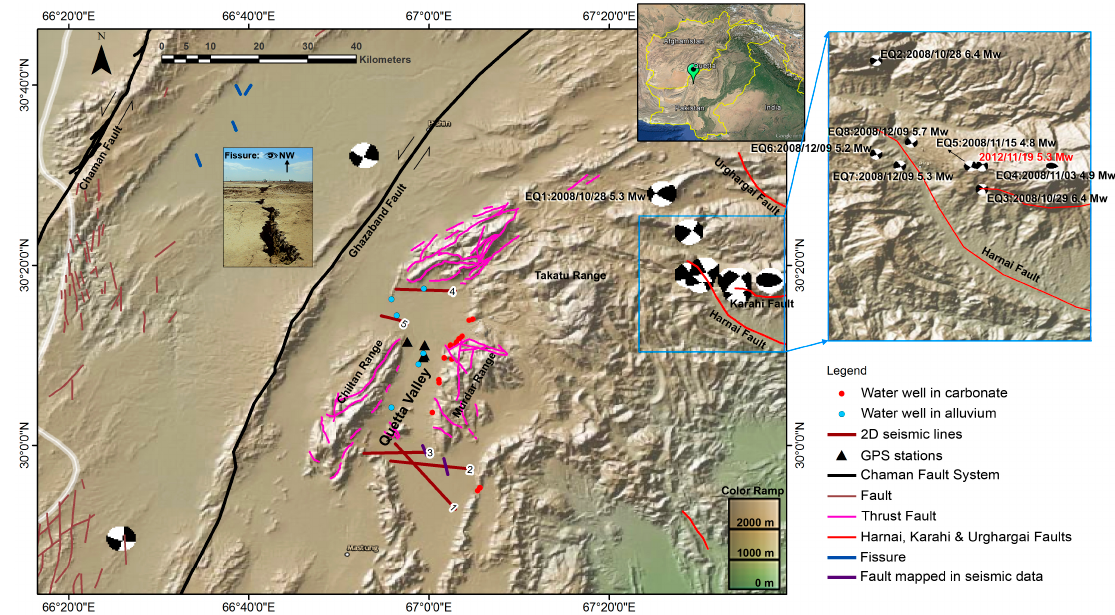
Figure 1. Map of major structures and earthquake hypocenters for the Quetta Valley and surrounding areas. The focal mechanisms of the October–December 2008 earthquakes are shown. Thrust faults in the Quetta Valley from Jones et al. [17] are also shown. Two blind thrust faults identified using 2D seismic data are shown in indigo. The beach ball symbol indicates the centroid-moment-tensor (CMT) solution [18,19].